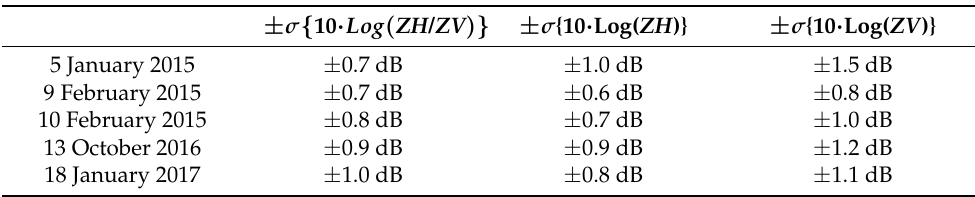
Table 6. Standard deviation of the differential reflectivity, the horizontal reflectivity and the vertical